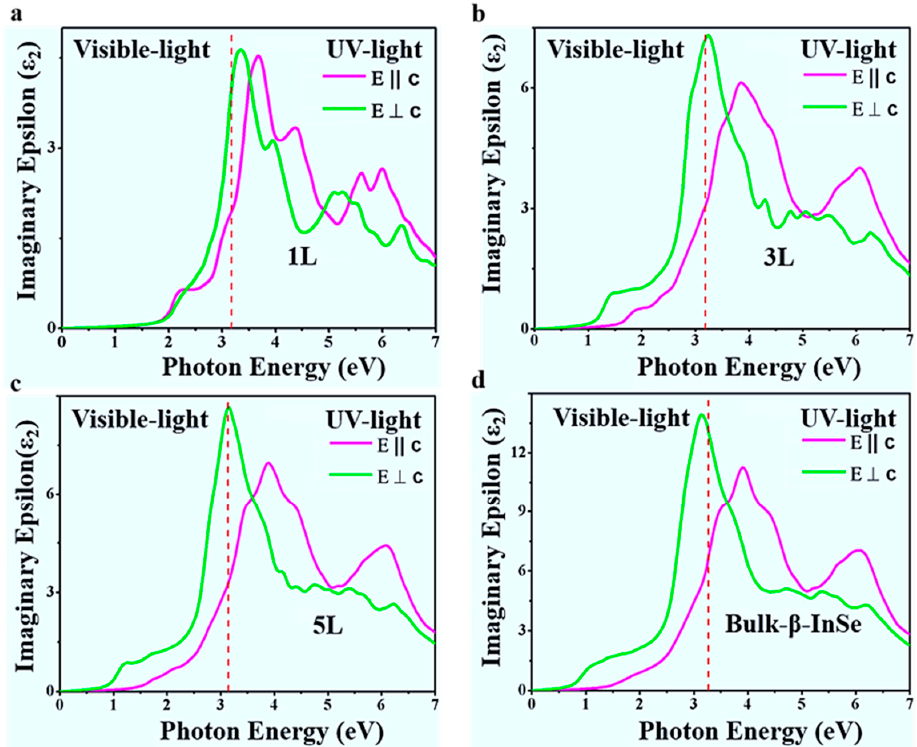
Figure 6. ( a – d ) Calculated imaginary part of the dielectric function a long x and z directions for β -InSe monolayer (1 L), few-layer (3 L and 5 L) and bulk β